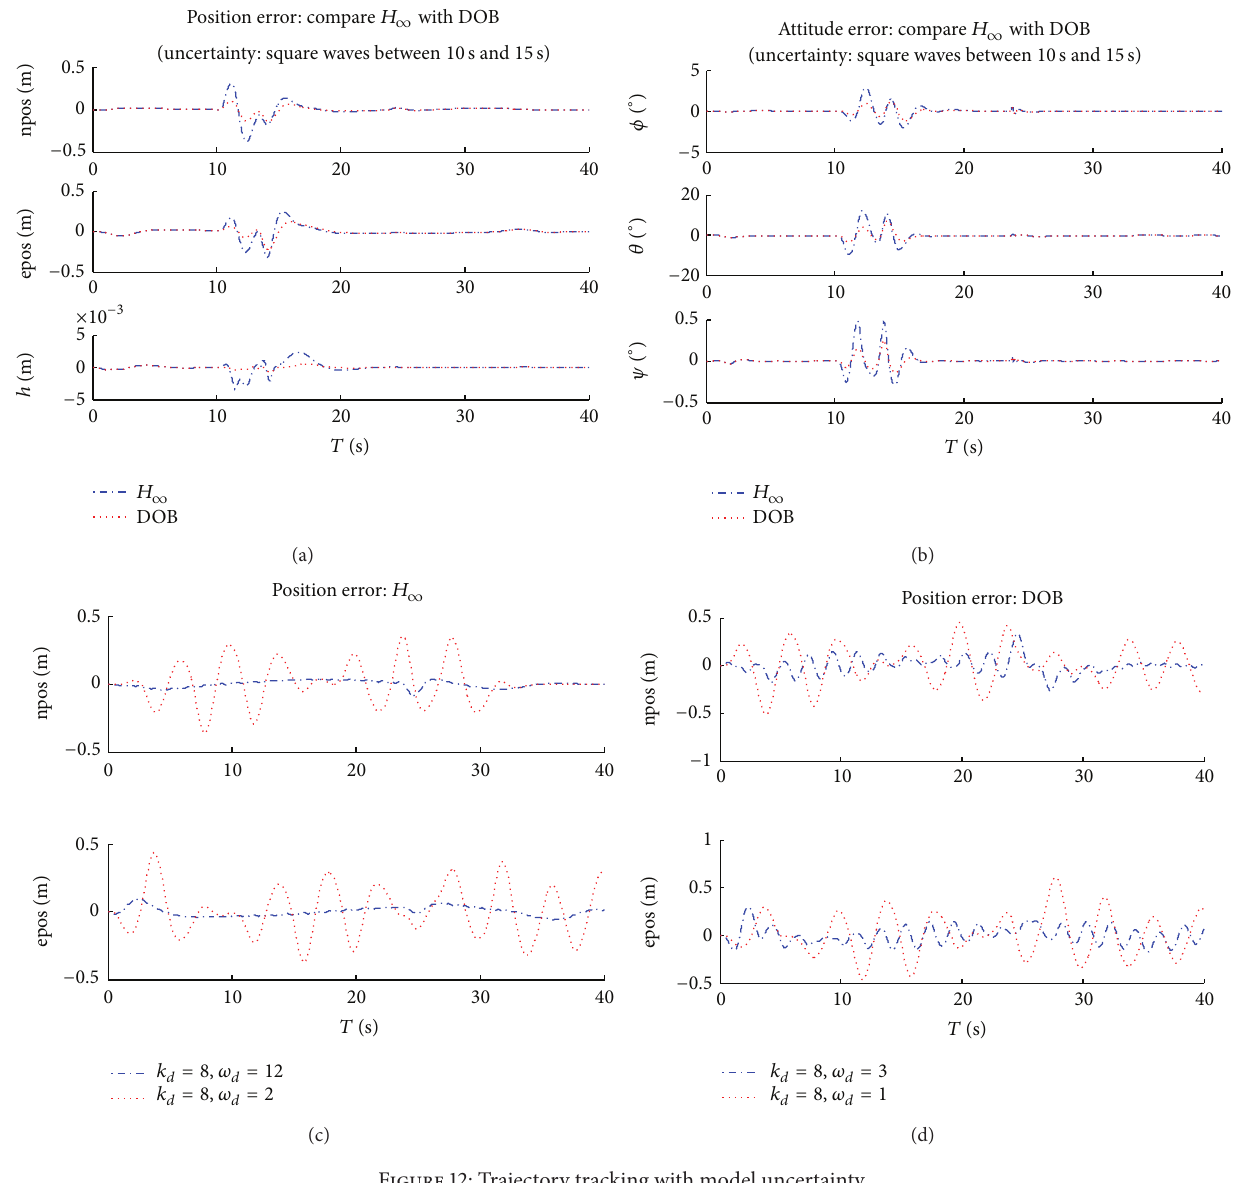
Figure 12: Trajectory tracking with model